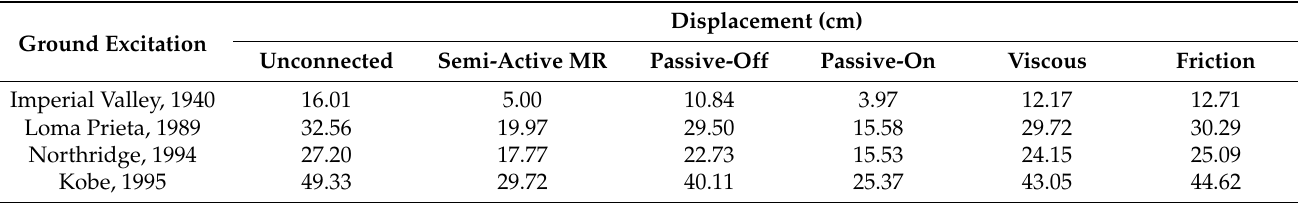
Table 4. Comparison of top storey peak displacement of the coupled stiff building under different control strategies when dampers are arranged in Configuration